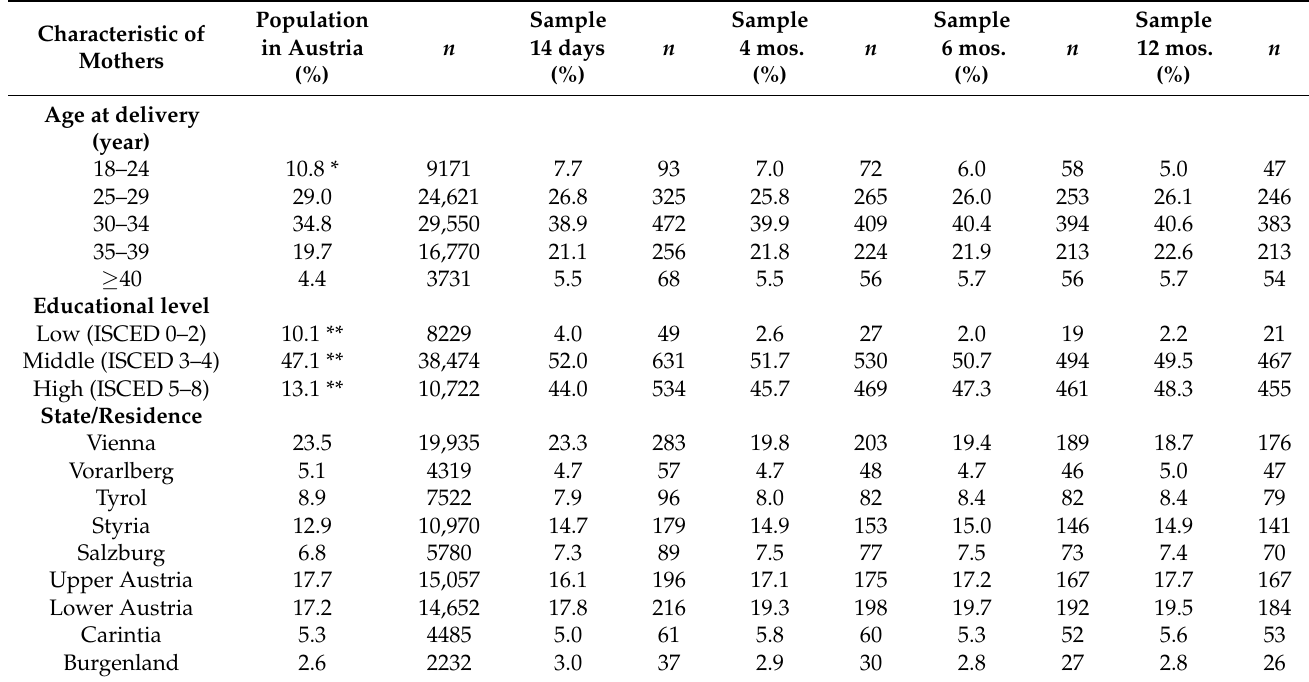
Table 1. Characteristics of the Austrian mothers’ population [29] and study sample ( n = 1214) at different time points. Characteristic of